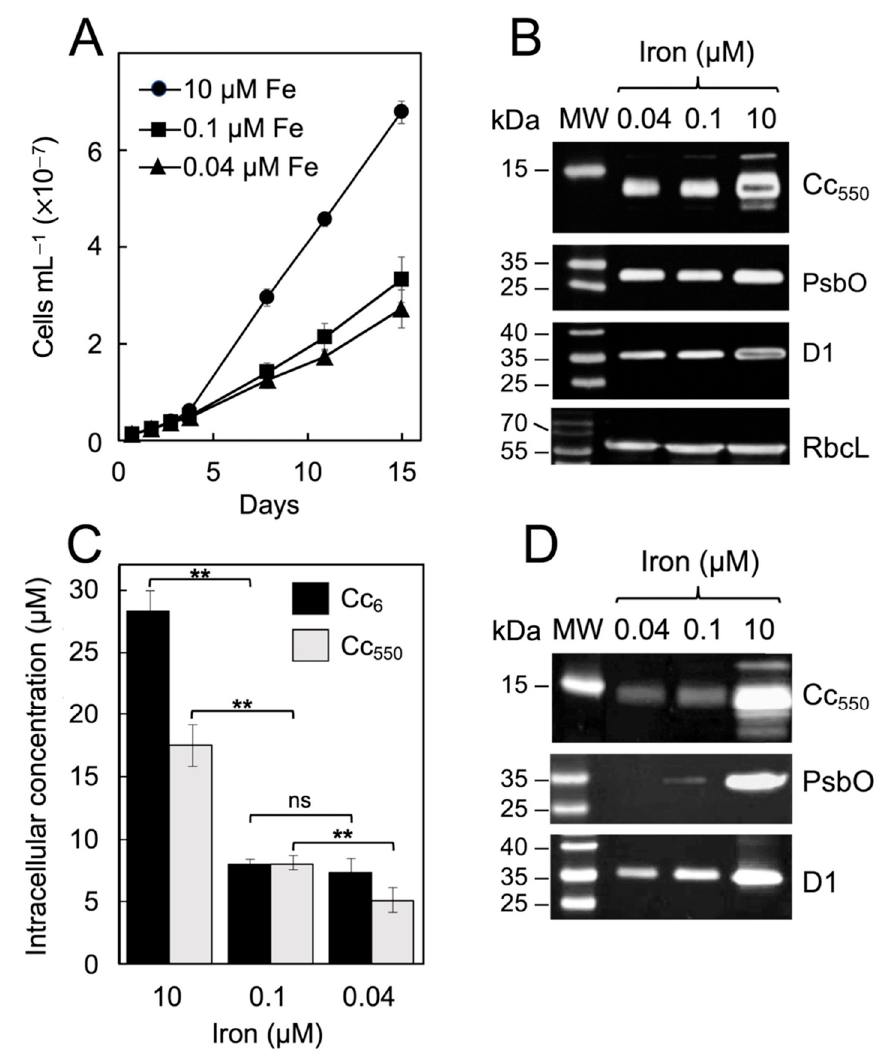
Figure 1. ( A ) Growth curves for P. tricornutum cultures under different iron concentrations. Mean values ± SD of measurements from 10 independent cultures are presented. ( B , D ) Representative Western-blots of different photosynthetic proteins in samples of whole cells ( B ) and membrane extracts ( D ) from P. tricornutum grown under iron-replete (10 µM iron) and iron-deficient (0.1 or 0.04 µM iron) conditions. MW: molecular weight standard; Cc 550 and PsbO, the extrinsic cytochrome c 550 and PsbO subunits of PSII; D1, the intrinsic D1 subunit of PSII; RbcL, control with the RuBisCO large subunit. Numbers on the left are the MW values corresponding to the molecular weight standard. Protein extracts: 20 µg for RuBisCO large subunit; 10 µg for PsbO and D1; 2.5 µg for Cc 550 . Membranes were incubated overnight with the following dilutions of the selected primary antibody: 1:1000 anti-Cc 550 and anti-RuBisCO large; 1:2000 anti-PsbO; 1:10,000 anti-D1. The complete Western-blots are shown in Figure S1 (Supplementary Material). ( C ) Intracellular concentrations of cytochrome c 6 (Cc 6 ) and Cc 550 measured by differential absorbance changes of P. tricornutum cells grown under different iron concentrations. Data represent mean values ± SD of at least four independent measurements. Double asterisks mark statistically different data groups ( p < 0.01); ns = not statistically different.